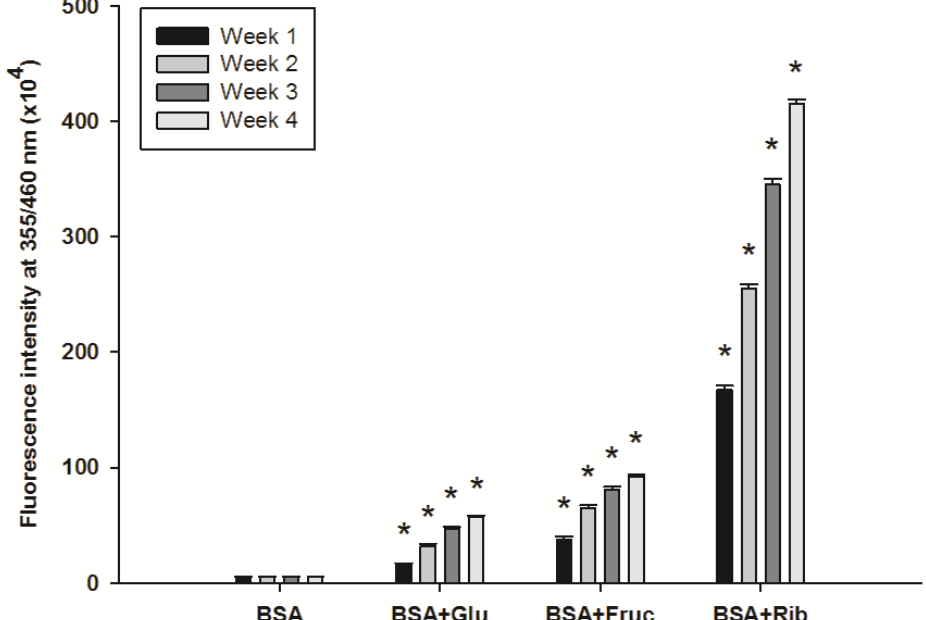
Figure 1. Time course of fluorescence intensity in BSA incubated with 500 mM glucose (Glu), 500 mM fructose (Fruc) or 100 mM ribose (Rib). The results are expressed as mean ± SEM ( n = 3). * p < 0.05 when compared to